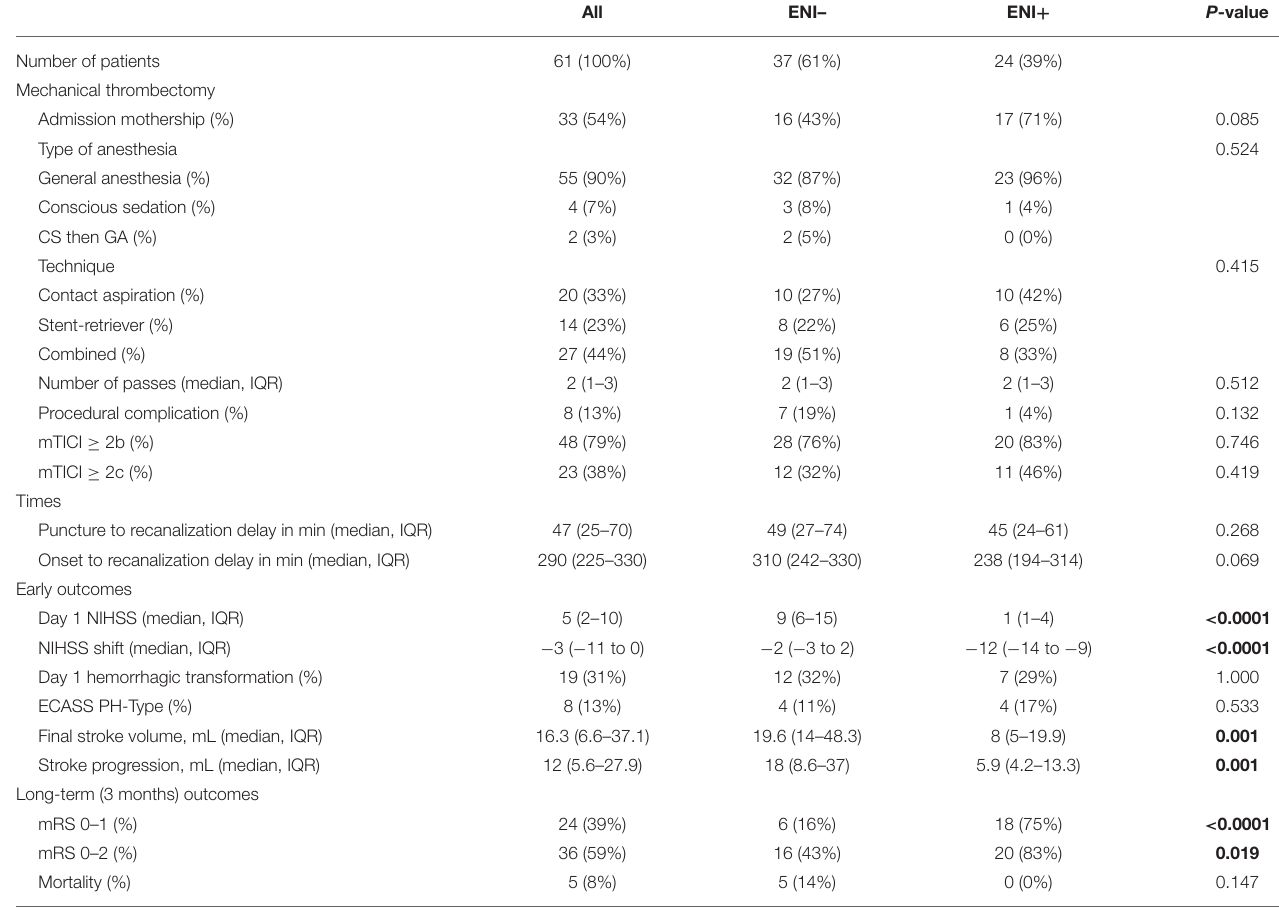
TABLE 2 | Procedural characteristics and clinical outcomes for patients stratified by ENI